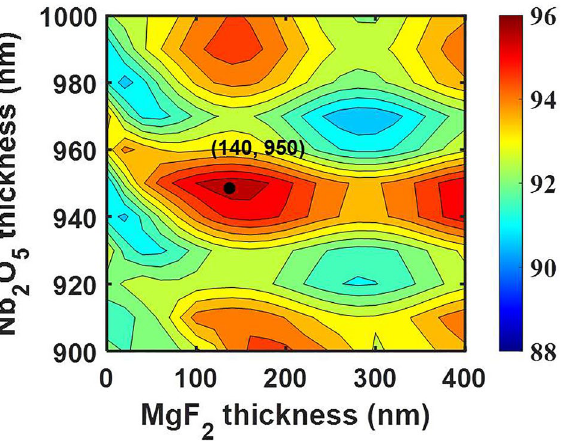
Figure 7. Overall PCE mapping of MgF 2 /Nb 2 O 5 hetero-nano-fin. Simulation of overall PCE as a function of MgF